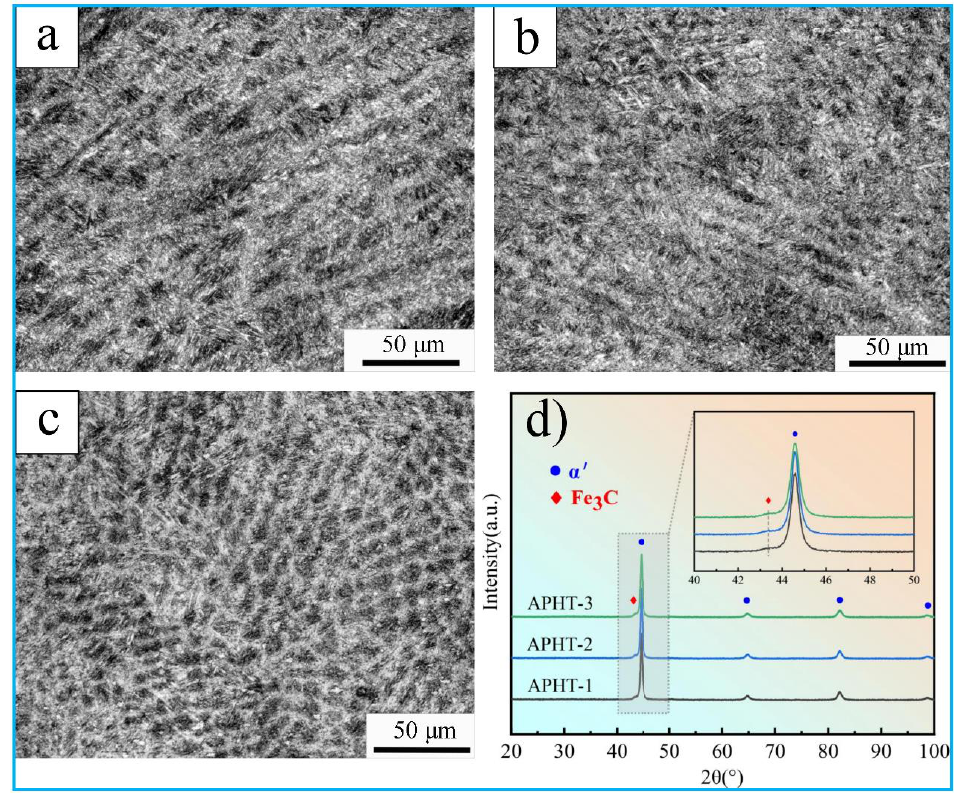
Figure 3. Optical micrographs and XRD patterns of three samples. ( a ) Optical micrograph of APHT-1. ( b ) Optical micrograph of APHT-2. ( c ) Optical micrograph of APHT-3. ( d ) XRD patterns of three samples.